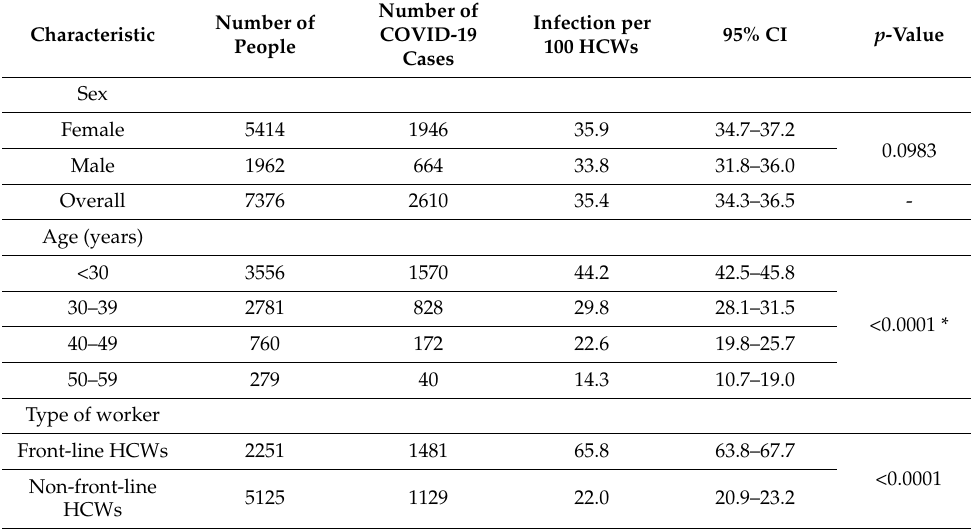
Table 1. Infection rate by sex, age, and type of